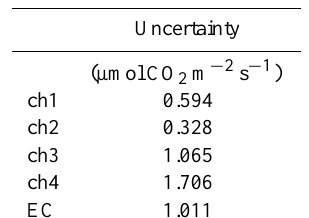
Table 4. Uncertainty values for the EC fluxes and the chamber mea- surements.